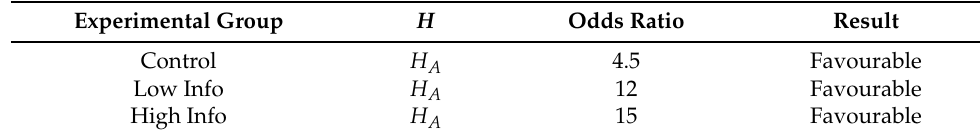
Table 5. β ’s sensitivity to considering the market price.